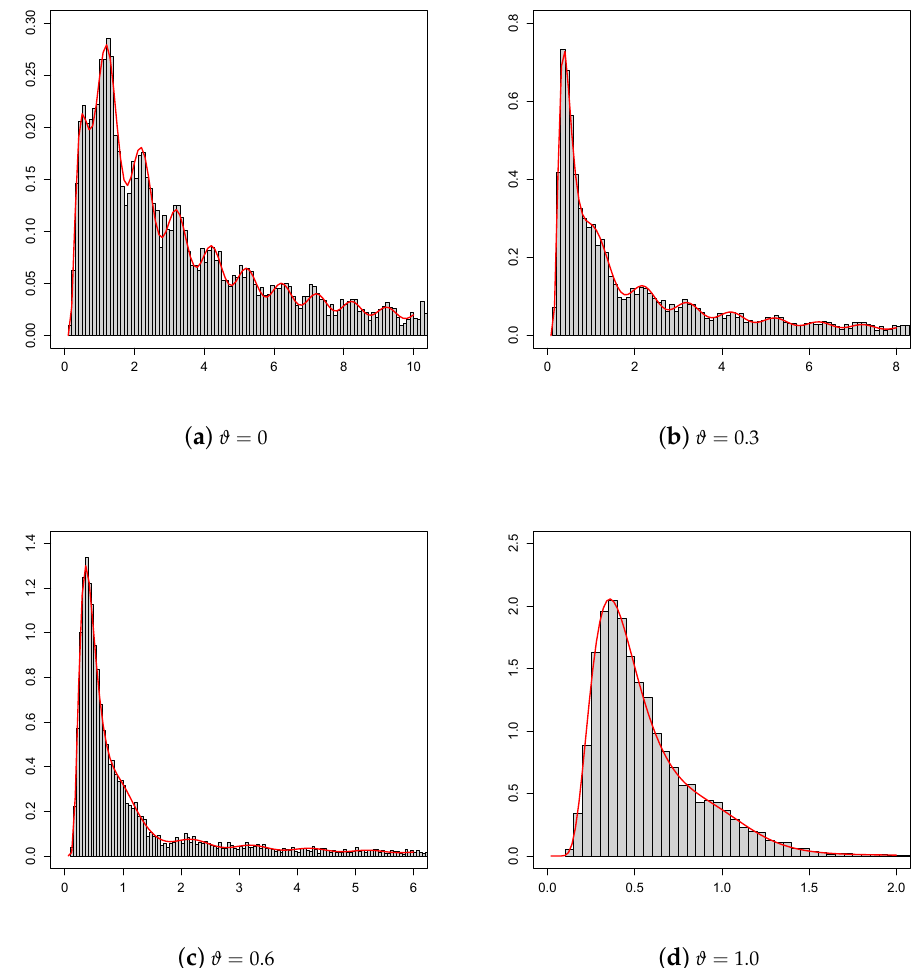
Figure 5. Histograms of FPT through the boundary S ( t ) = 2 − 1.8 t − 0.12 sin 2 ( π t ) for the process Z ( t ) , given in (51), are compared with the FPT densities (solid curve), given in (55), for y = 0, τ = 0 and γ = 1.5, ν = 0.1, Q =